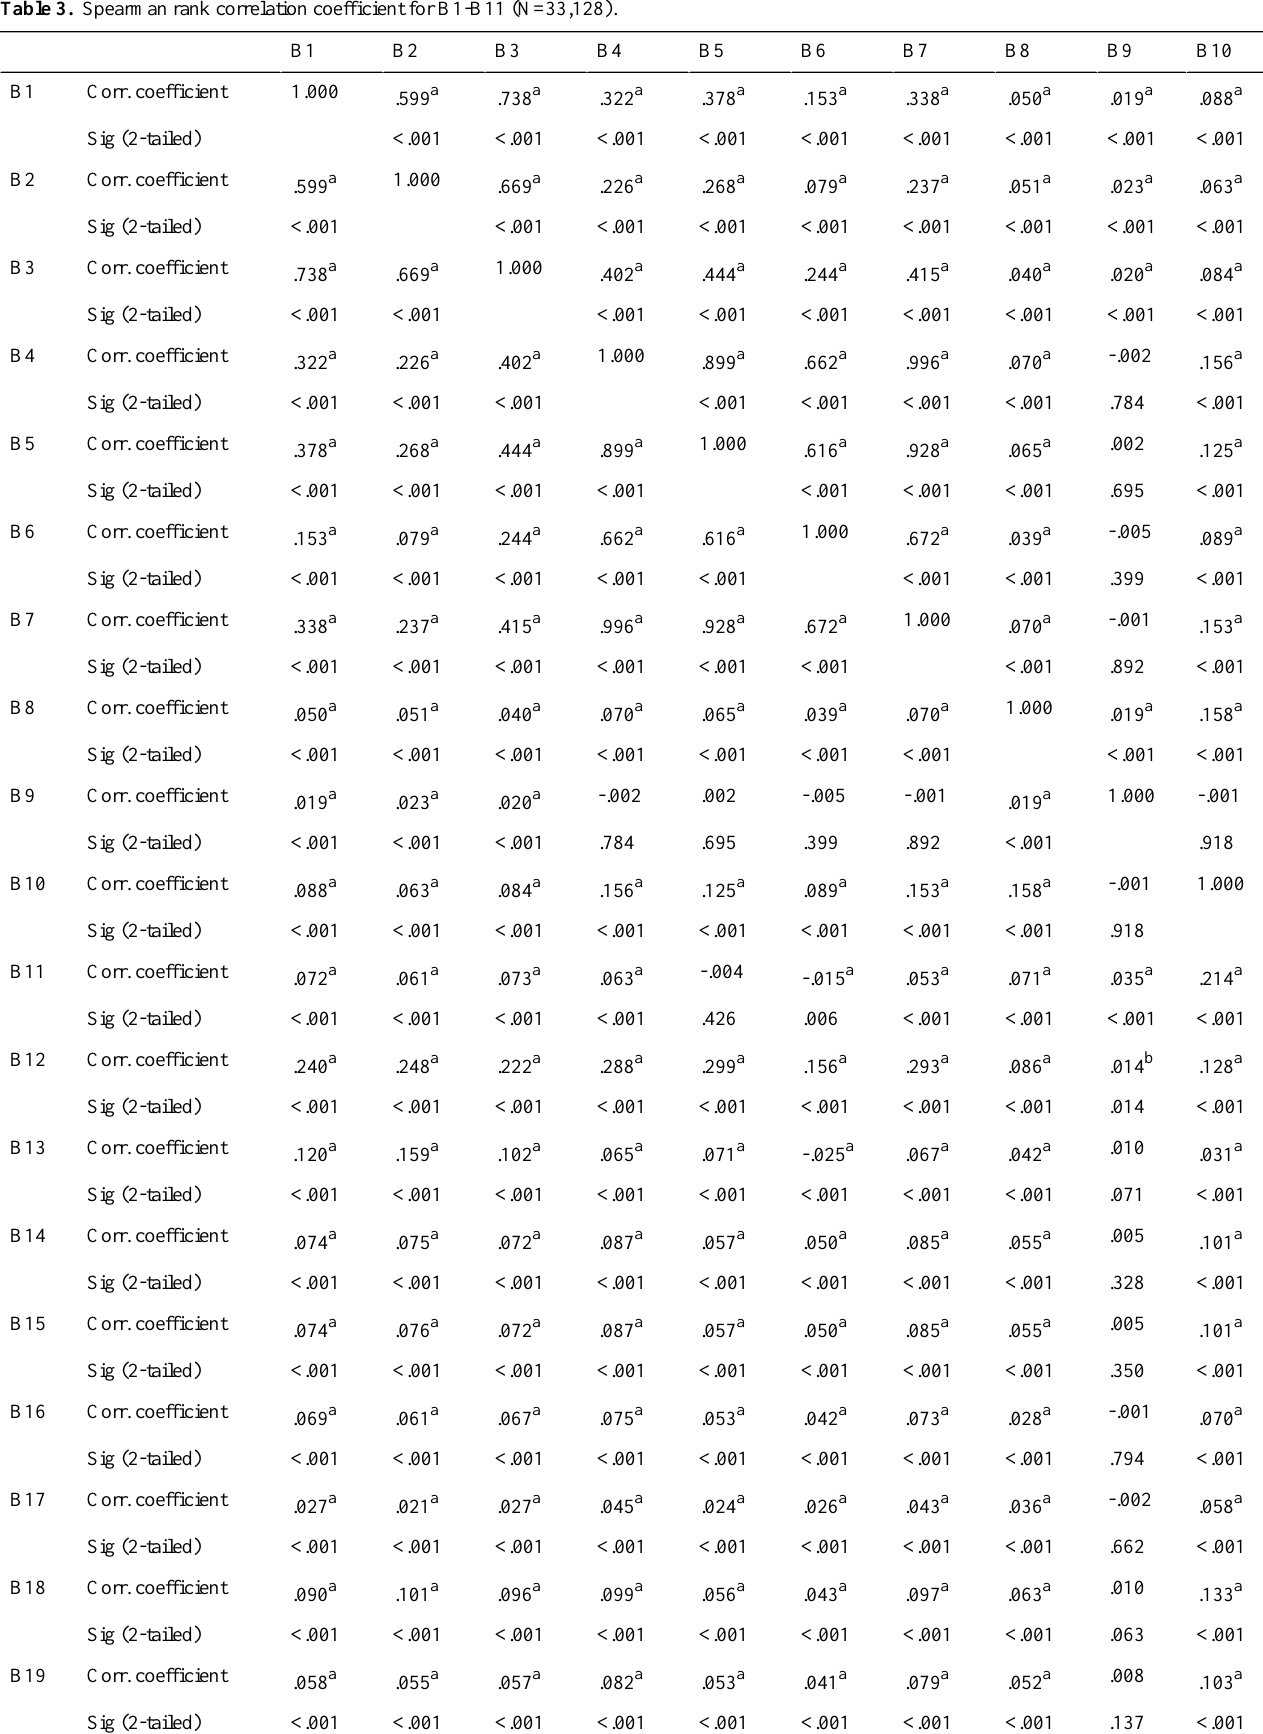
Table 3. Spearman rank correlation coefficient for B1-B11 (N=33,128).